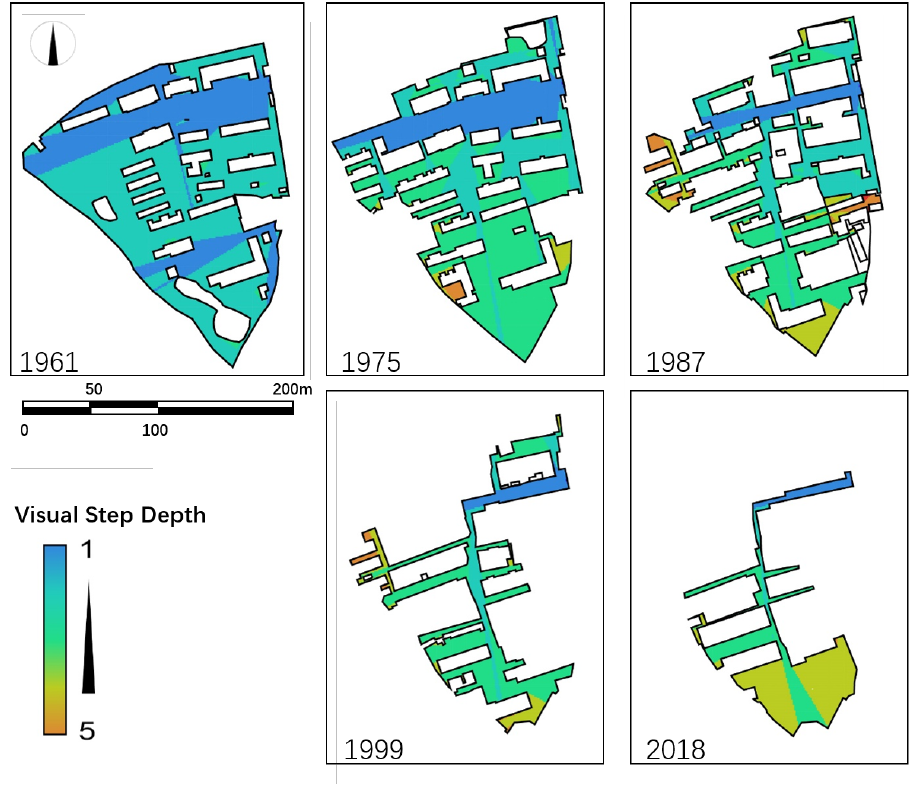
Figure 8. Visual step depth of the AMS compound (1961–2018). Connectivity values refer to the strength of the connection between the cell and all other cells in the public space (Figure 9). In a residential environment, a place with a higher connectivity value has better potential as a social or common space. From 1961 to 1999, the analysis showed that the overall connectivity in the AMS compound decreased significantly. In 2018, the connectivity remained poor, except for the new emerged common space (a neighbourhood park) in the south